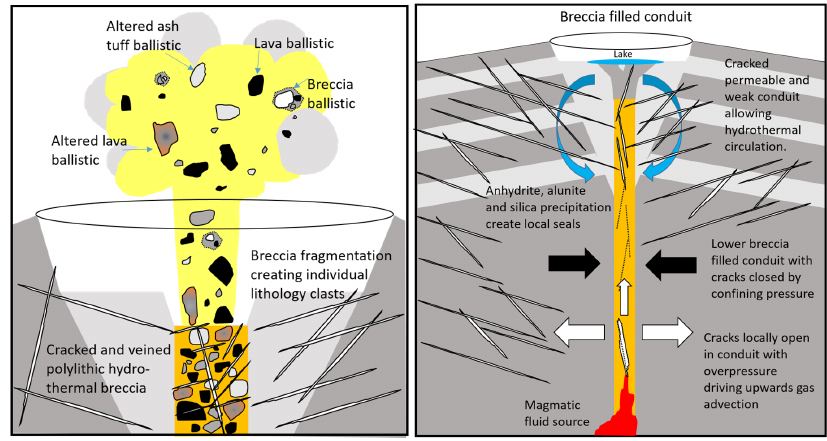
Figure 9. Proposed model of Whakaari conduit ( a ) near the surface and ( b ) eruption.